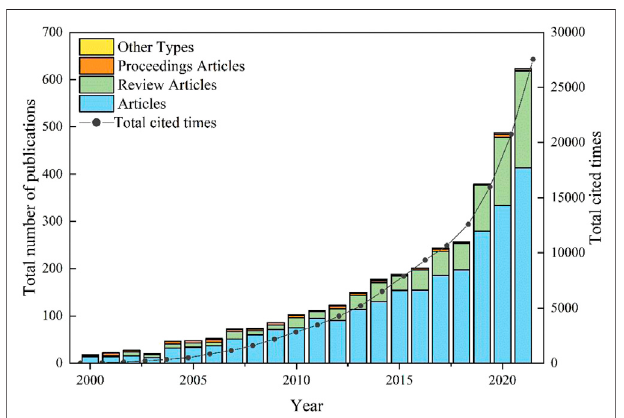
FIGURE 1| Number ofpublications and citation frequency from 2000 to